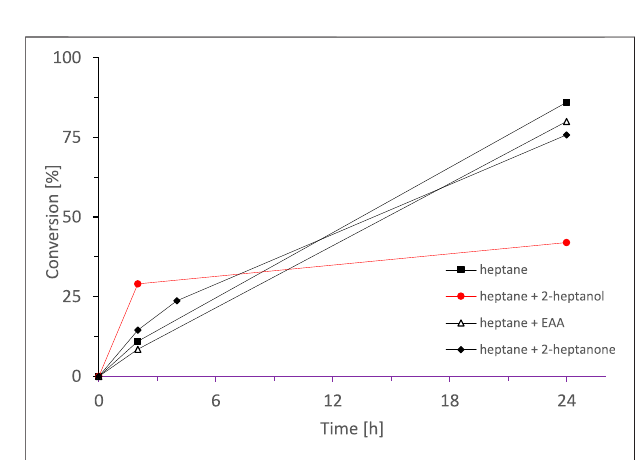
FIGURE 8 | Effect of pre-incubation of the Sy ADH whole cell-biocatalyst in the presence of different reagents on its catalytic activity. Lyophilised cells were incubated for 72 h in ( ■ ) n- heptane, ( C ) rac- heptan-2-ol (in n- heptane), ( Δ )ethylacetoacetate(in n- heptane)and( ◆ )2-heptanone(in n- heptane), then the remaining components were added. Reaction conditions: [ rac - heptan-2-ol] = 100 mM, [Ethyl acetoacetate] = 100 mM (1 equiv.), [NADP + ] = 0.5 mM, [ E. coli C43(DE3) pET24b- syadh ] = 5 mg × mL − 1 , [KPi, pH 7] = 1 M (10% v/v), [ n- heptane] = 90% v/v, total volume: 10 ml, T = 30 ° C, 230